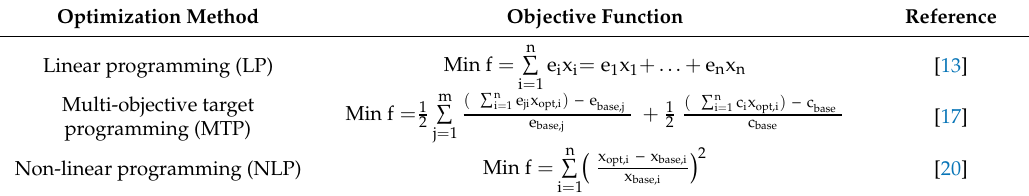
Table 1. Definition of objective functions of di ff erent types of optimization methods used to design sustainable diets. e, environmental impact; x, amount (mass) of a food product; n, total amount of food products; opt, optimal diet; base, baseline diet; c, cost; i: food item; j, environmental